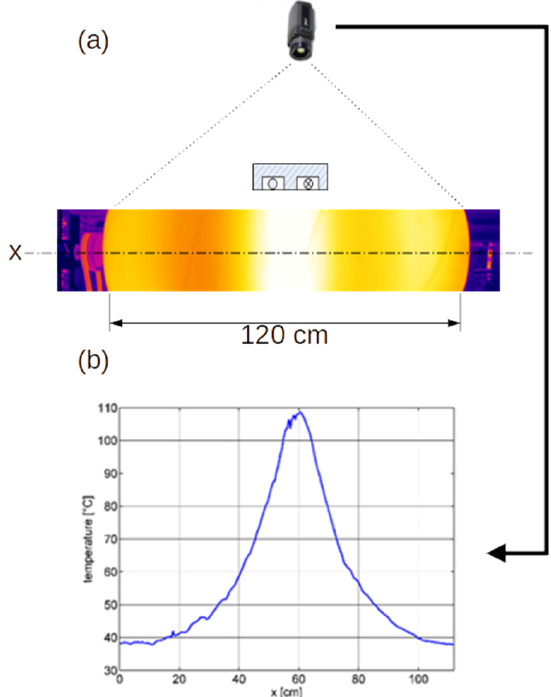
Figure 5. Example of measuring the surface temperature of a rotating cylinder using a thermal imaging camera. ( a ) Two-dimensional temperature map of the surface of the rotating cylinder processed by an IR camera. ( b ) One-dimensional temperature distribution along the generatrix of cylinder x.